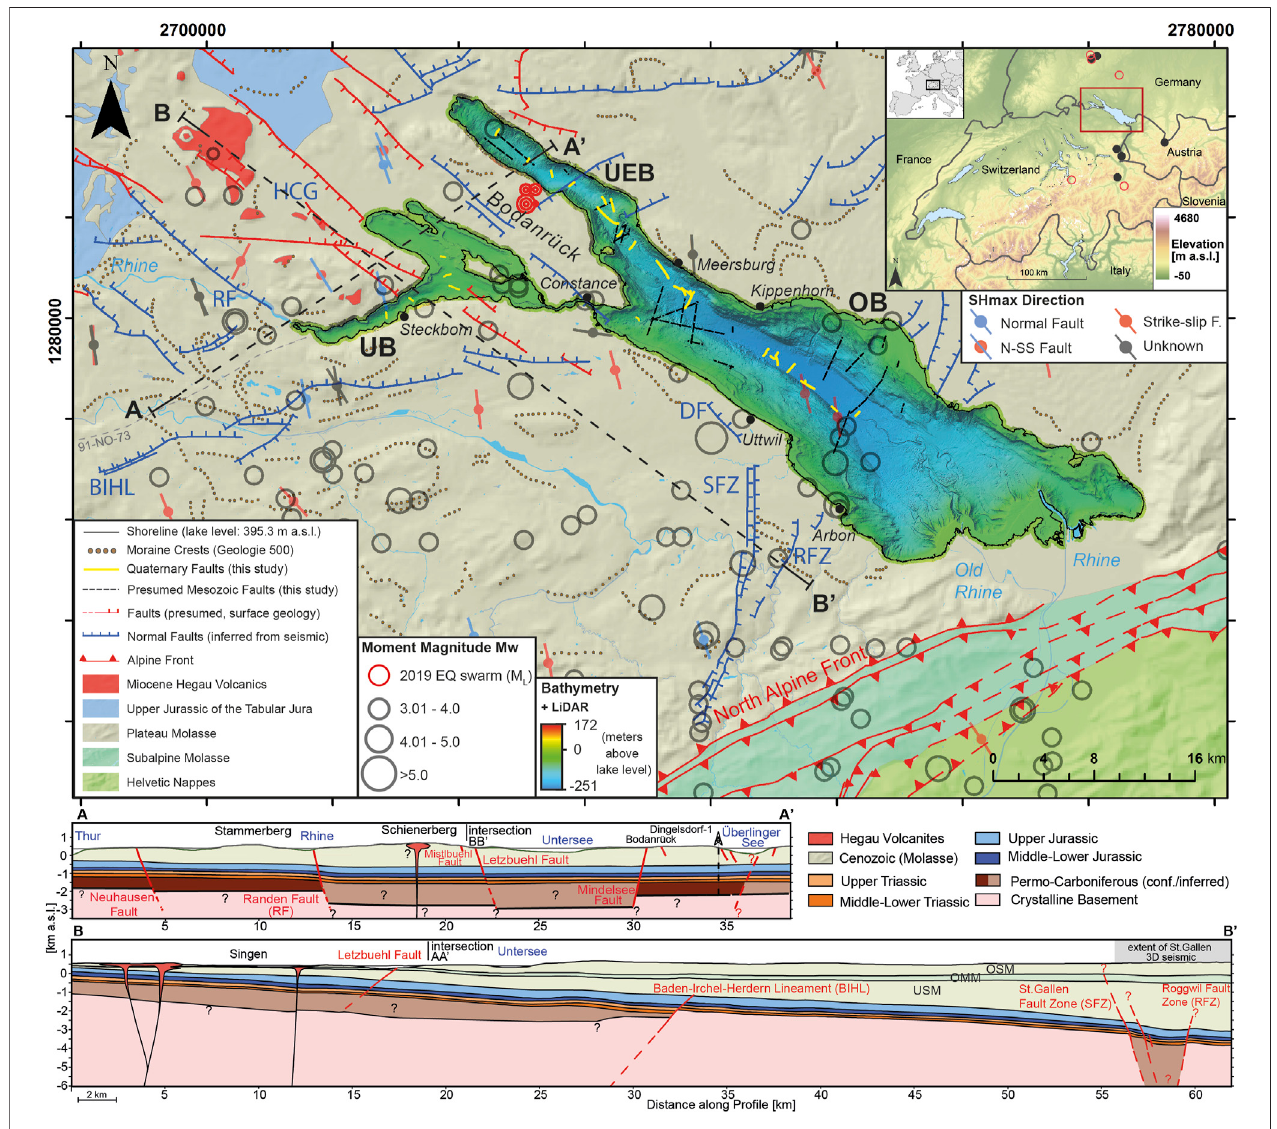
FIGURE 1 | Tectonic overview of the Lake Constance area with bathymetric map superimposed (Wessels et al., 2015). The moraine crests are derived from swisstopo (2005a). Fault compilation from tectonic map (swisstopo, 2005b), geologic vector dataset (swisstopo, 2017), onshore seismic, and fi eld mapping (Heuberger et al., 2016). The fault mapping from offshore seismic data is marked as yellow and black dashed lines. Moment magnitudes of historically documented and instrumentally recorded earthquakes are shown. The 2019 earthquake swarm on the peninsula is marked as red circles. Maximum horizontal stress directions are from Heidbach et al. (2018). OB: Obersee Basin, UEB: Überlinger Basin, UB: Untersee Basin. Fault names are given in Supplementary Table S1 . Coordinate system is swiss grid CH 1903+/LV95. Inset shows elevation data created from SRTM one Arc-Second (courtesy of the United States, Geological Survey), the extent of the fi gure and borders of neighboring countries, as well as earthquakes with moment magnitude ≥ 5 in a radius of 100 km (red circles, ECOS-09) and moment magnitude ≥ 4.5 in a radius of 80 km around the Lake Constance region within the time period 1880 – 1925 (black dots, ECOS-09). Pro fi le A: NE-SW simpli fi ed tectonic cross section. Different Molasse units are not shown for readability. Pro fi le B: NW-SE simpli fi ed tectonic cross section. The extent of the St. Gallen 3D seismic onshore survey is indicated (Heuberger et al., 2016). USM: Lower Freshwater Molasse, OMM: Upper Marine Molasse, OSM: Upper Freshwater